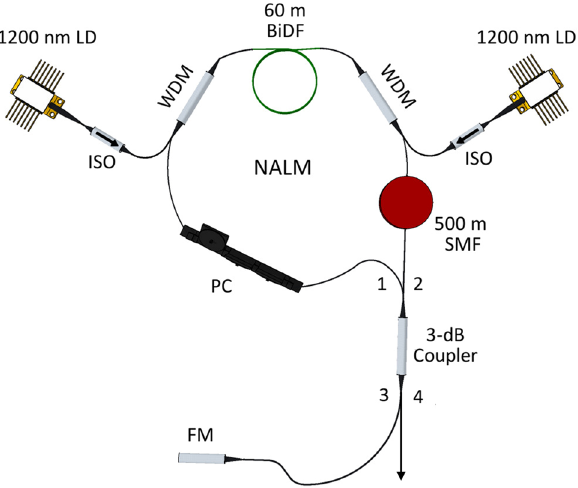
Figure 1. Schematic diagram of the DSR F9 BiDFL. This figure was drawn using SketchUp Make 2017 (Basic), Software Version: Windows 64-bit 17.2.2555, available at https:// www. sketc hup. com/ downl oad/